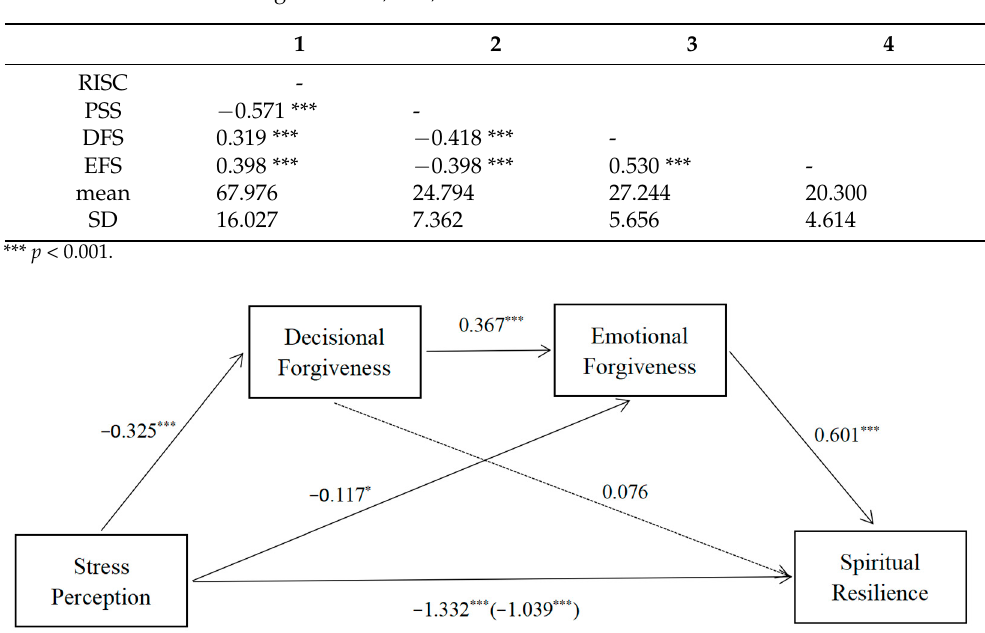
Table 4. Correlations among CD-RISC, PSS, DFS and EFS.